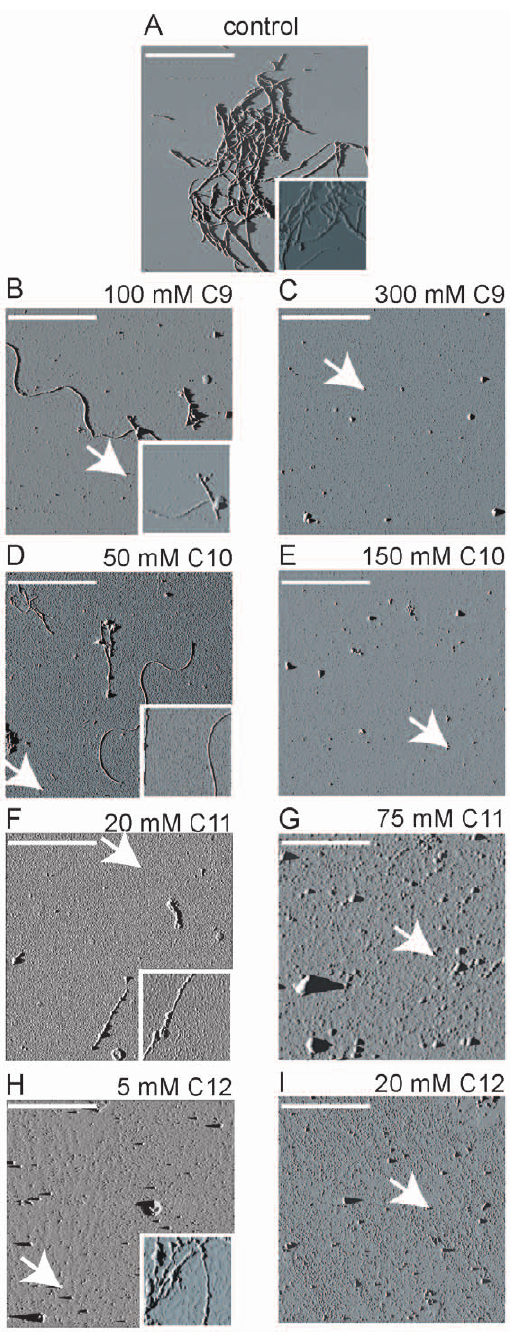
Figure 4. Aliquots of the samples from Figure 2 were probed to see the morphologies of A b 42 aggregates generated in the presence of varying concentrations of fatty acids either near or above the CMC by atomic force microscopy (AFM). A) control ; B&C) 100 & 300 mM C9; D & E) 50 & 150 mM C10; F & G) 20 & 75 mM C11; H & I) 5 & 20 mM C12. Amplitude images with scale of 0–0.4 volts are presented. The white arrows indicate typical oligomeric samples. The white scale bar represents 1 m m and each square represents 5 6 5 m m field and the inset shows a different field of dimensions 1 6 1 m m.